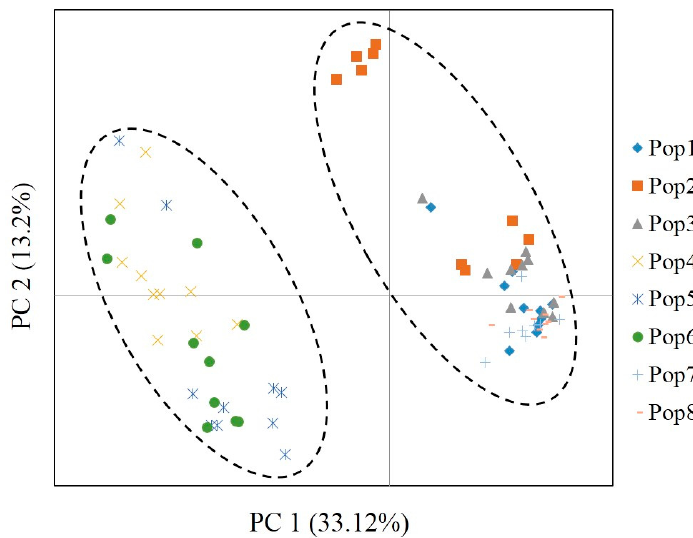
Figure 3. Principal component analysis based on 20 EST-SSR markers in P. koraiensis .